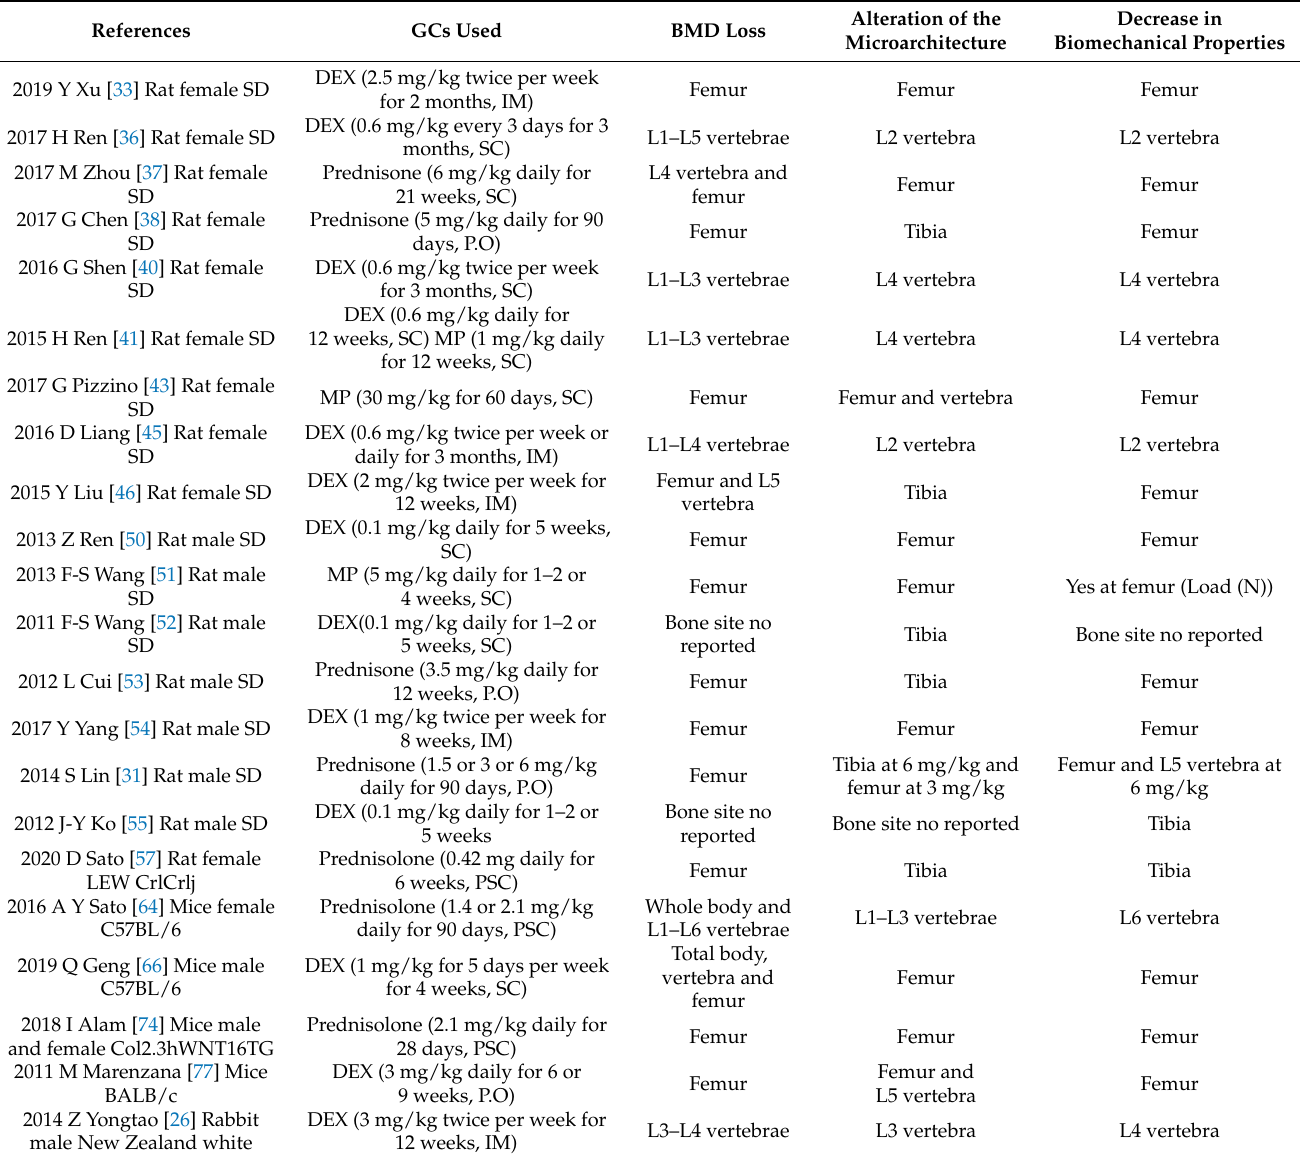
Table 10. Studies responding to our definition of a good GIOP animal model. SD = Sprague